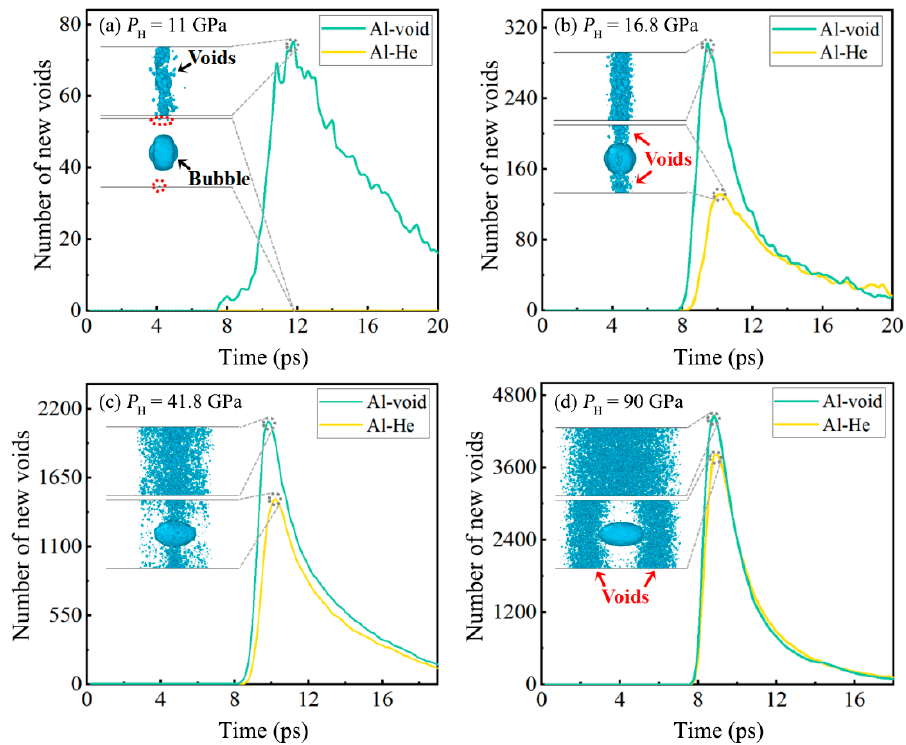
Figure 8. The variations of void number between Al-void and Al–He. ( a – d ) shows the comparison Figure 8. The difference of void number between Al-void and Al–He. ( a – d ) shows the comparison of of these two samples under different Hugoniot states. The microscopic images of the void distribu- these two samples for different Hugoniot states. The microscopic images of the void distribution at tion at peak moment are presented. peak moment are